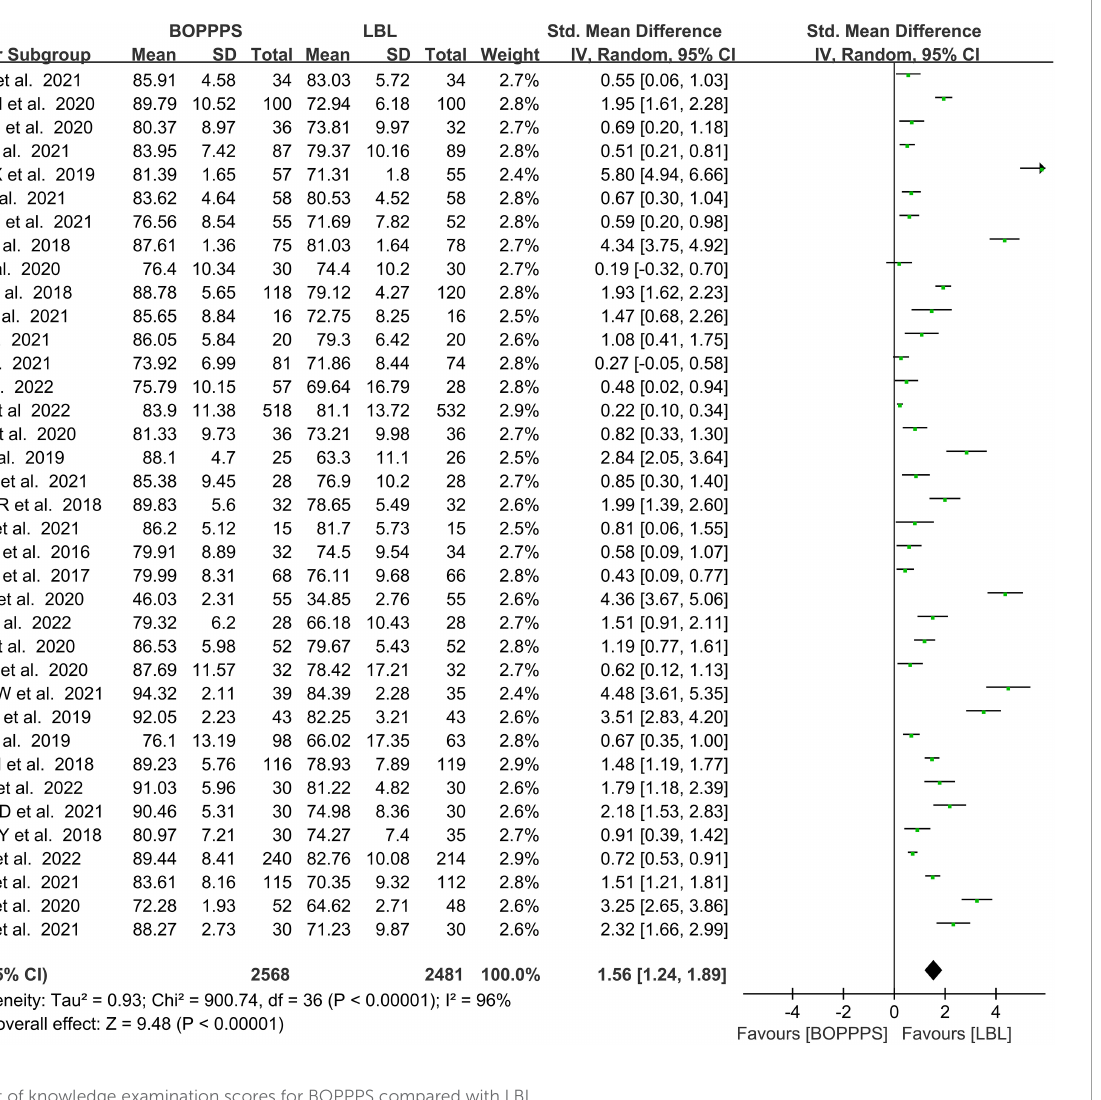
FIGURE5 Forest plot of knowledge examination scores for BOPPPS compared with